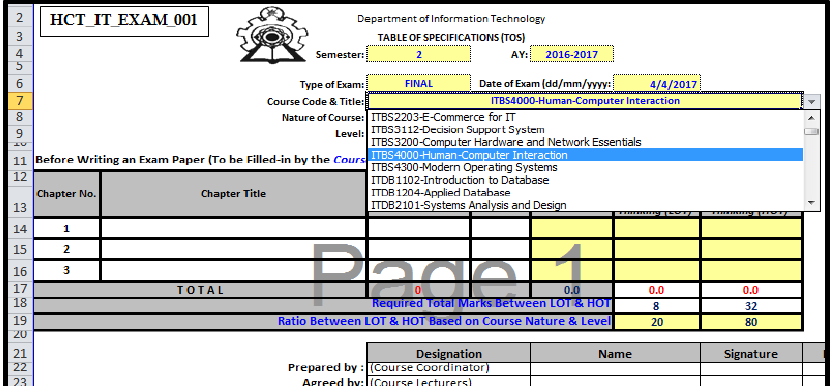
Fig. 4. Spreadsheet Prototype of the Test Blueprint